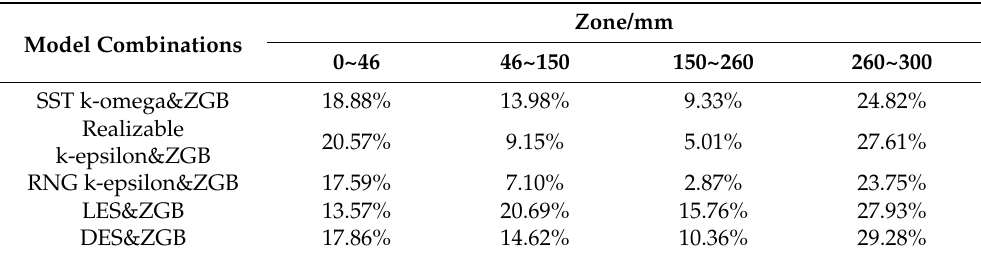
Table 6. The error of average cross-sectional x 1 flow rate at 67 bar differential pressure compared to test